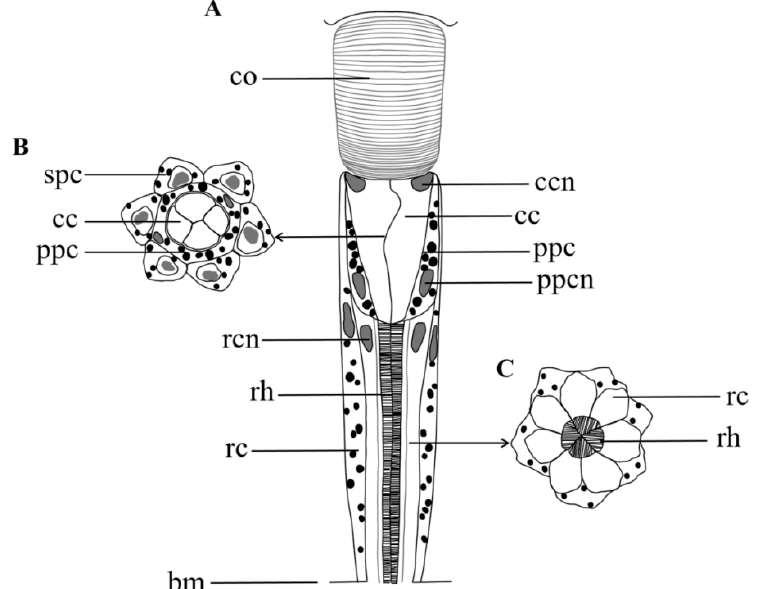
Figure 6. Semischematic drawing of one ommatidium of Arge similis . ( A ) Longitudinal view of ommatidium. ( B ) Transverse section through the region of the crystalline cone. ( C ) Transverse section through the region of the retinular cells and the rhabdom. co: cornea; cc: crystalline cone; ccn: nuclei of cone cell; ppc: primary pigment cell; spc: secondary pigment cells; ppcn: nuclei of primary pigment cell; rc: retinular cell; rcn: nuclei of retinular cell; rh: rhabdom; bm: basement membrane.